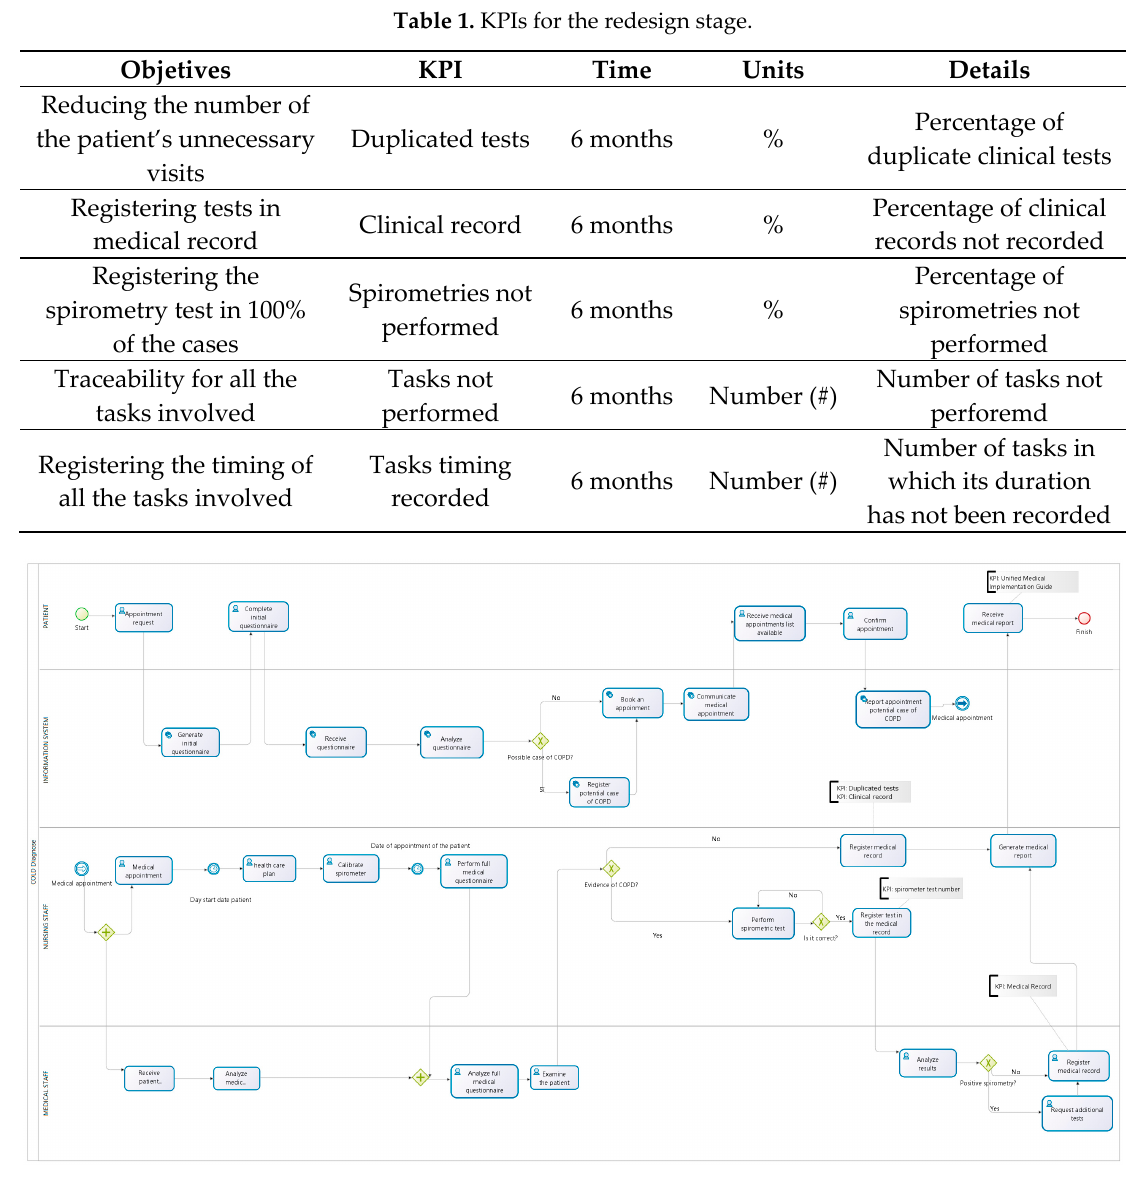
Figure 3. COPD clinical process redesign using